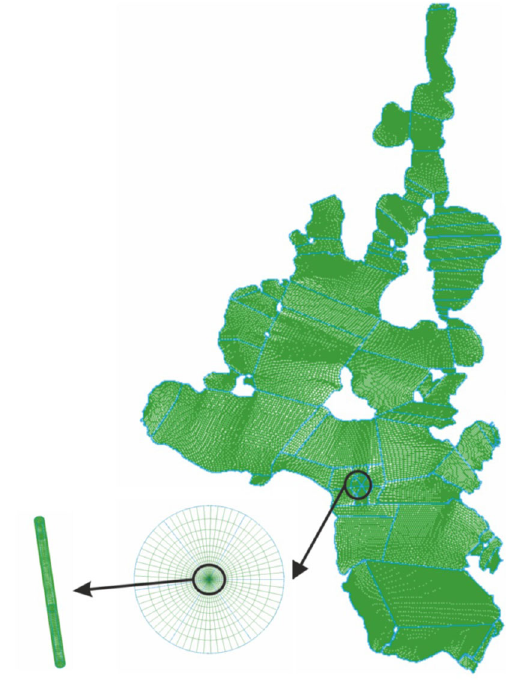
Fig. 2 3D-grids model of Lake